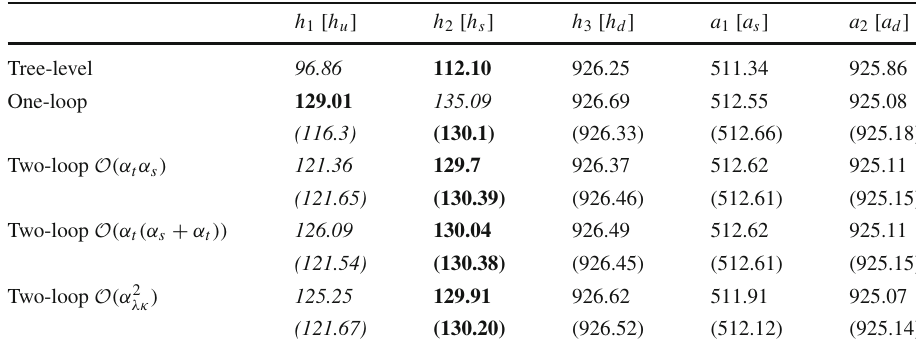
Table 2 P2OS : Mass values in GeV and main components of the neutral Higgs bosons at tree-level, one-loop, two-loop α ) , two-loop O (α t s (α + α )) and at two-loop O (α t s t ) obtained by using OS O (α 2 λκ (DR) renormalisation in the top/stop sector. Italic numbers relate to states that are dominantly h u -like. Bold numbers relate to dominantly h s -like